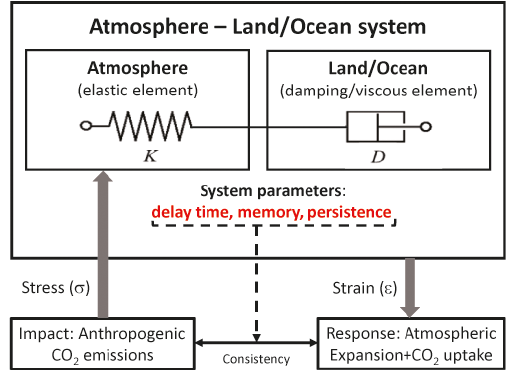
Figure 1. Rheological model to capture the stress–strain behav- ior of the global atmosphere–land and ocean system as a Maxwell body consisting of elastic (atmosphere) and damping (land–ocean) elements. The stress (in units of Pa; known) is given by the car- bon (CO 2 ) emissions from fossil fuel burning and land use, while the strain (in units of 1; assumed exponential, otherwise unknown) is given by the expansion of the atmosphere by volume and uptake of CO 2 by sinks. Independent estimates of K and D , the compres- sion and damping characteristics of the MB, allow its stress–strain behavior to be captured and adjusted until consistency is achieved (see